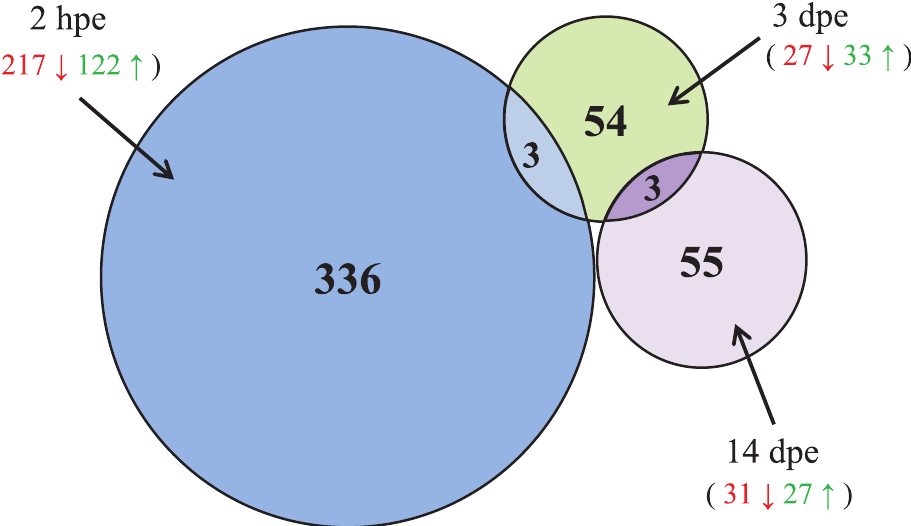
Fig 2. Venn diagram of DEG in RVFV infected Cx . pipiens mosquitoes. The Venn diagram represents the number of DEG in response to RVFV at different time-points (2 hpe, 3 dpe and 14 dpe). In red, the number of down-regulated genes, in green the number of up-regulated